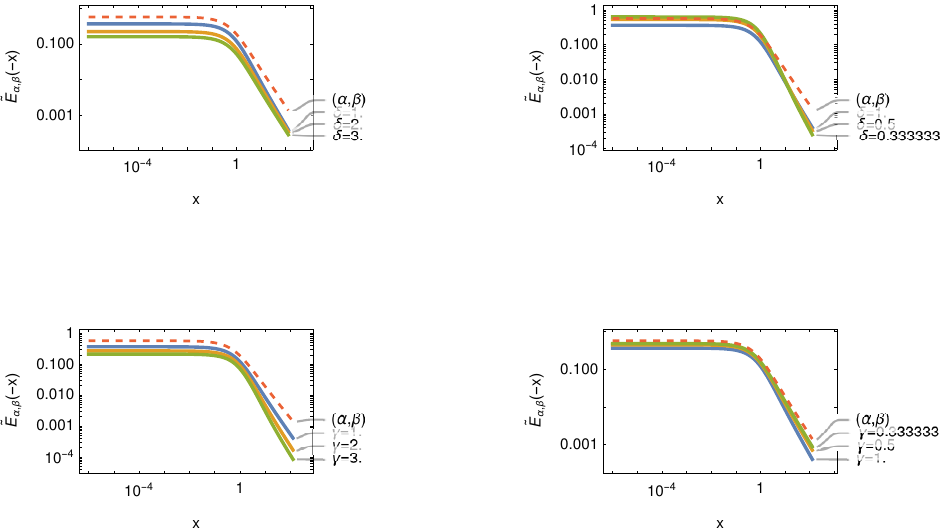
Figure 14. Variation of parameters (indicated in the panels) for the weighted Mittag-Leffler function ( − x ) = ˜ E ( − x ) using α = 1/3 and β = 1/2. The top row uses γ = 1and the bottom row δ = 1. E δ , γ α , β α , β The Mittag-Leffler function E α . β ( − x ) is shown as reference (dashed line). The number of Sinc points in all approximations is N =